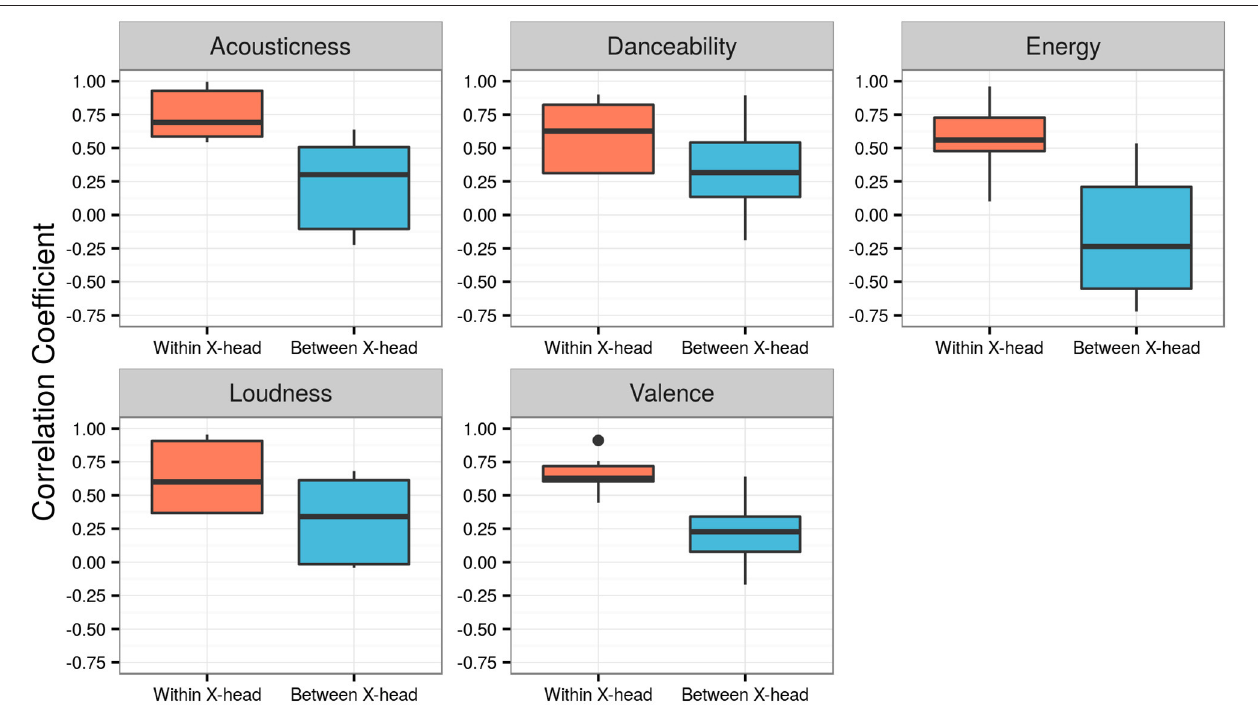
FIGURE 5 | Boxplots of the five features within Analysis 1. Red boxes represent the within X-head coefficients; blue boxes represent the between X-head coefficients.